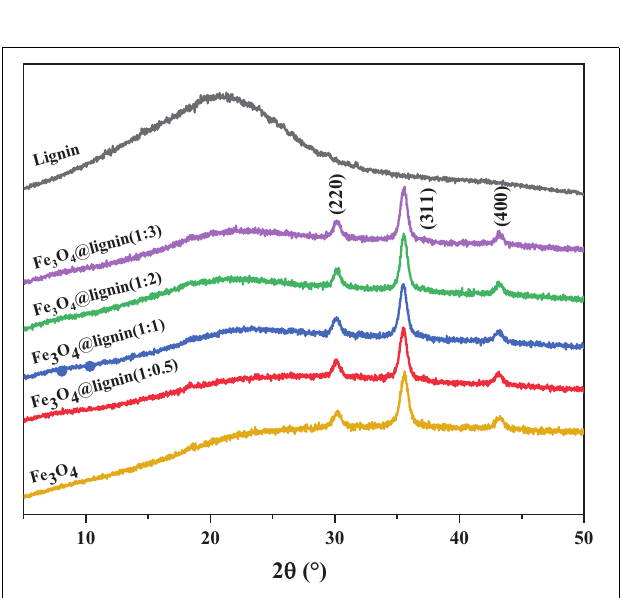
FIGURE 3 | XRD spectra of magnetic lignin nanoparticles.